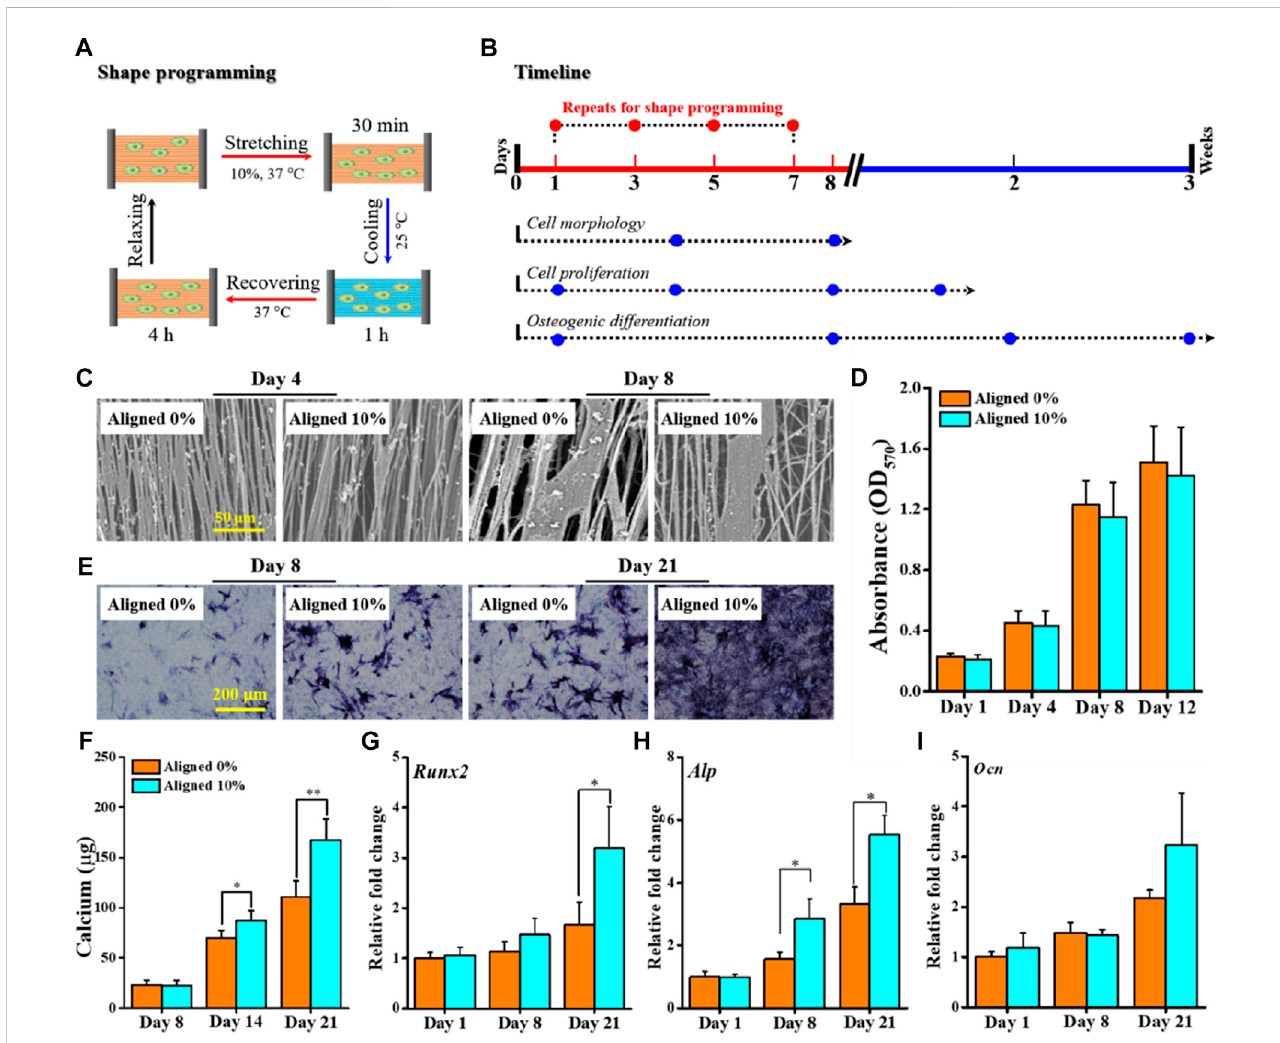
FIGURE 6 Proof-of-concept test of applying aligned fi brous substrate-based SME for regulating osteogenic differentiation. (A) Schematic representation of a complete cycle of shape-programming and recovery processes applied for in vitro cell culture with BMSCs. (B) Timeline depicting the process of cell culture and the designated biological assays to be performed at the speci fi ed time points. (C) SEM images of BMSCs cultured for 4 – 8 days; scale bar is 50 μ m. (D) Histogram of BMSC proliferation by the MTT assay. (E, F) Osteogenic differentiation evaluated by ALP staining (E) and quanti fi cation of calcium deposits (F) . (G – I) Gene expression levels of representative osteogenic markers Runx2 (G) , Alp (H) , and Ocn (I) at 1, 8, and 21